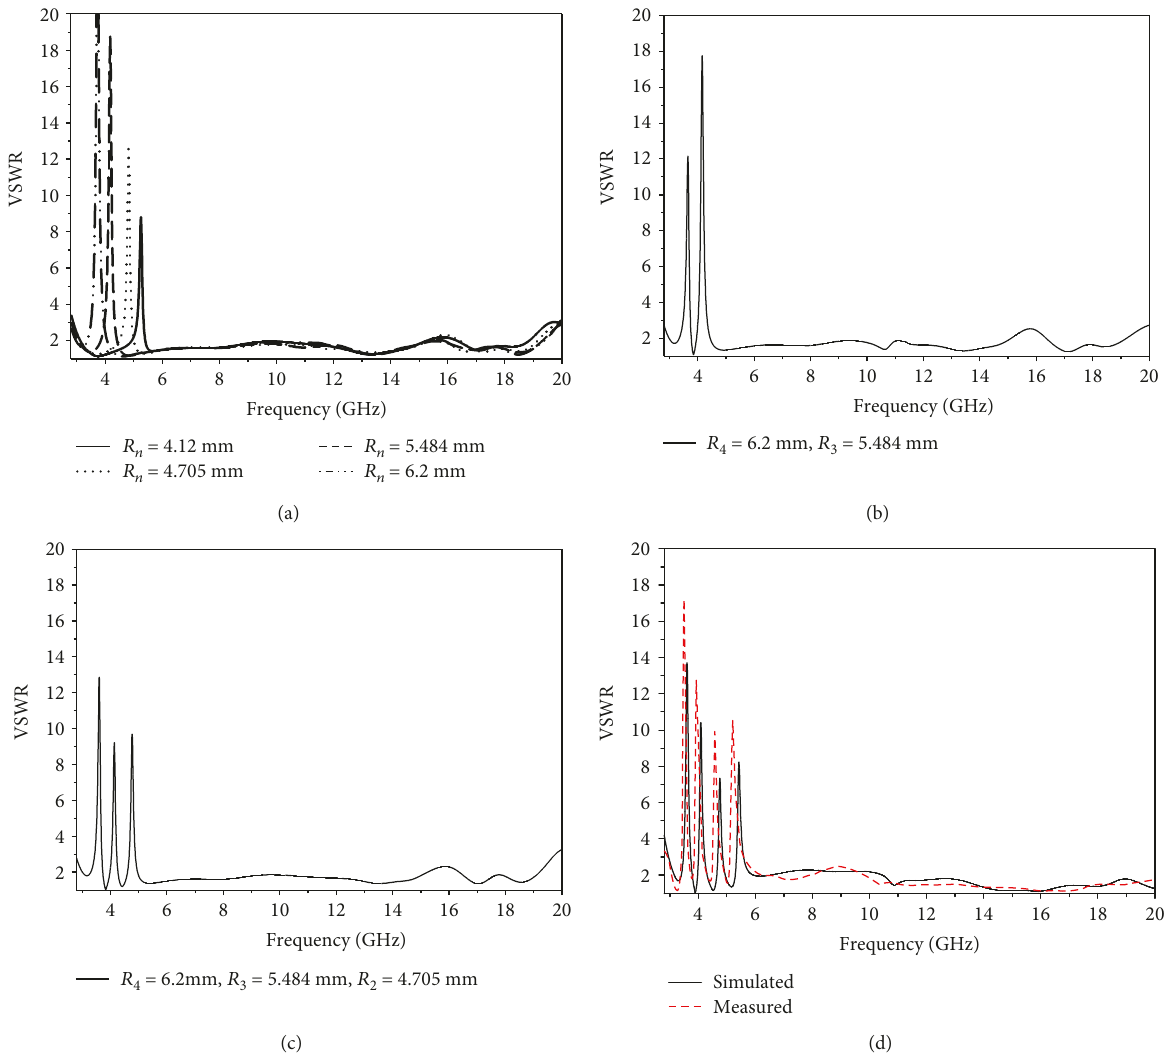
Figure 5: Notch frequency for di ff erent geometrical etched slot parameters. (a) Notch at the di ff erent frequency band from varying the parameter R n . (b) Notch at the WiMAX band and the C-band from parameters R C-band, and INSAT band from parameters R European C-band, INSAT band, and WLAN band from parameters R